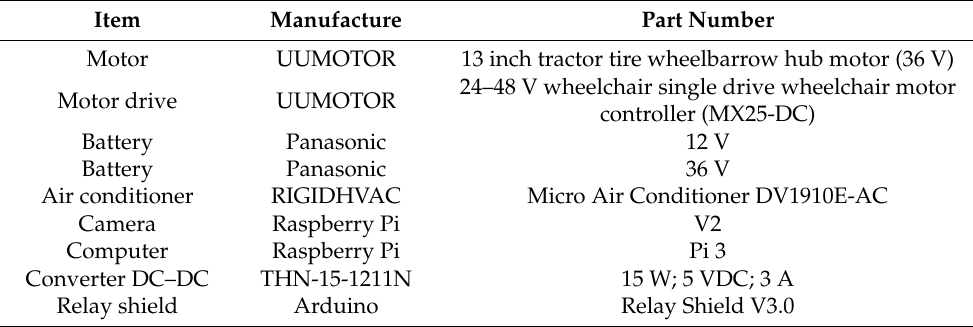
Table 4. Air-conditioner robot components